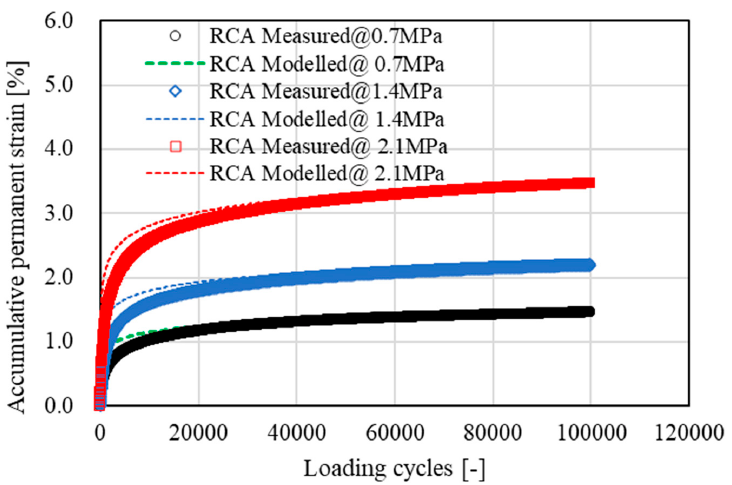
Figure 10. Development of accumulative permanent strain of recycled concrete aggregate (RCA) under cyclic loading. Table 4. Fitting results of model parameters for the development of resilient modulus and the accu- mulative permanent strain.